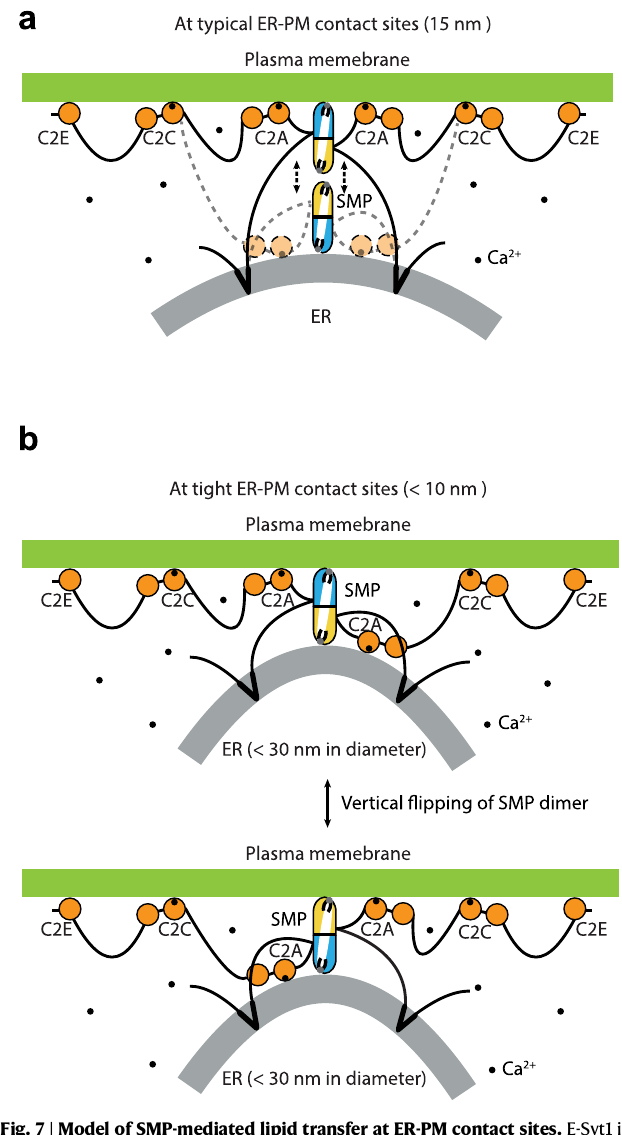
Fig. 7 | Model of SMP-mediated lipid transfer at ER-PM contact sites. E-Syt1 is anchored to the tubular ER via its N-terminal hydrophobic hairpin and interacts with the PM by its Ca 2+ -binding C2C and C2E domain. The tip region of the SMP dimer associates with the subdomain of the tubular ER and acidic-lipid-enriched region in the PM for transferring lipids as a “ shuttle ” at typical ER-PM contact sites a and as a “ screw propeller ” b at tight ER-PM contact sites. The Ca 2+ -binding C2A domainisincloseproximitytotheSMPdomainandbindstoeithertheERorPMto helptheSMPdomainstayatthemembrane.TheCa 2+ ionsareshownassmallblack puri fi ed from the supernatant by an Ni-NTA column. After elution using 0.1% (w/v) Anapoe X-100 and 200 mM imidazole in buffer A, the proteinwaspassedthroughadesaltingcolumnwith0.1%(w/v)Anapoe X-100 in buffer A to remove the imidazole. The puri fi ed E-Syt1 was mixed with liposomes at a protein to lipid ratio of 1:500 at 4°C for 1 h with gentle shaking. The fi nal Anapoe X-100 concentration was added to 0.1% (w/v) and lipid concentration was 1 mM. The reconstitution of proteins into liposomes was achieved by removing the detergent with bio-beads SM-2 resin (Bio-Rad).